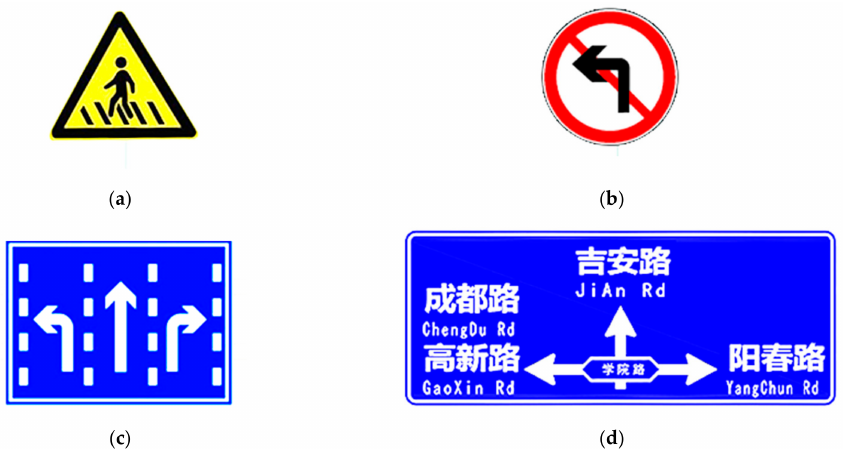
Figure 4. The sample design of the traffic sign layout in the experiment. ( a ) Warning sign. ( b ) Prohi- bition sign. ( c ) Indicator sign. ( d ) Guide sign.